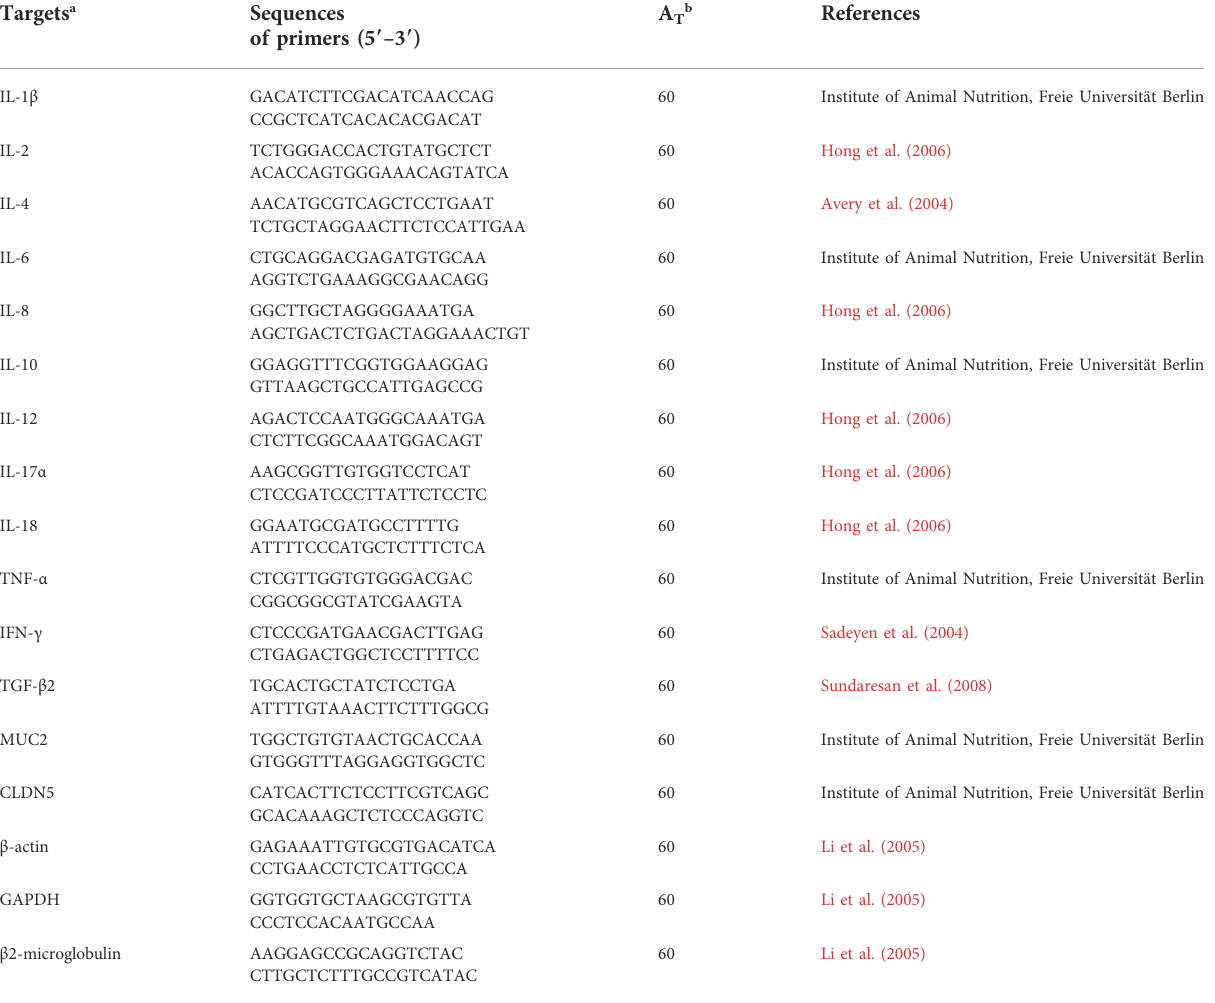
TABLE 2 Primer sequences used for RT-PCR